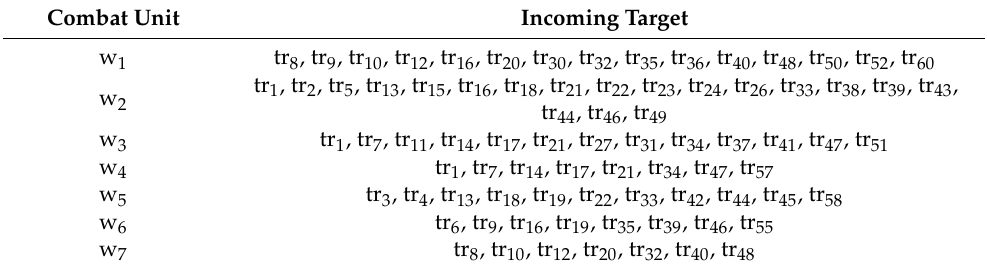
Table 10. Target assignment result.